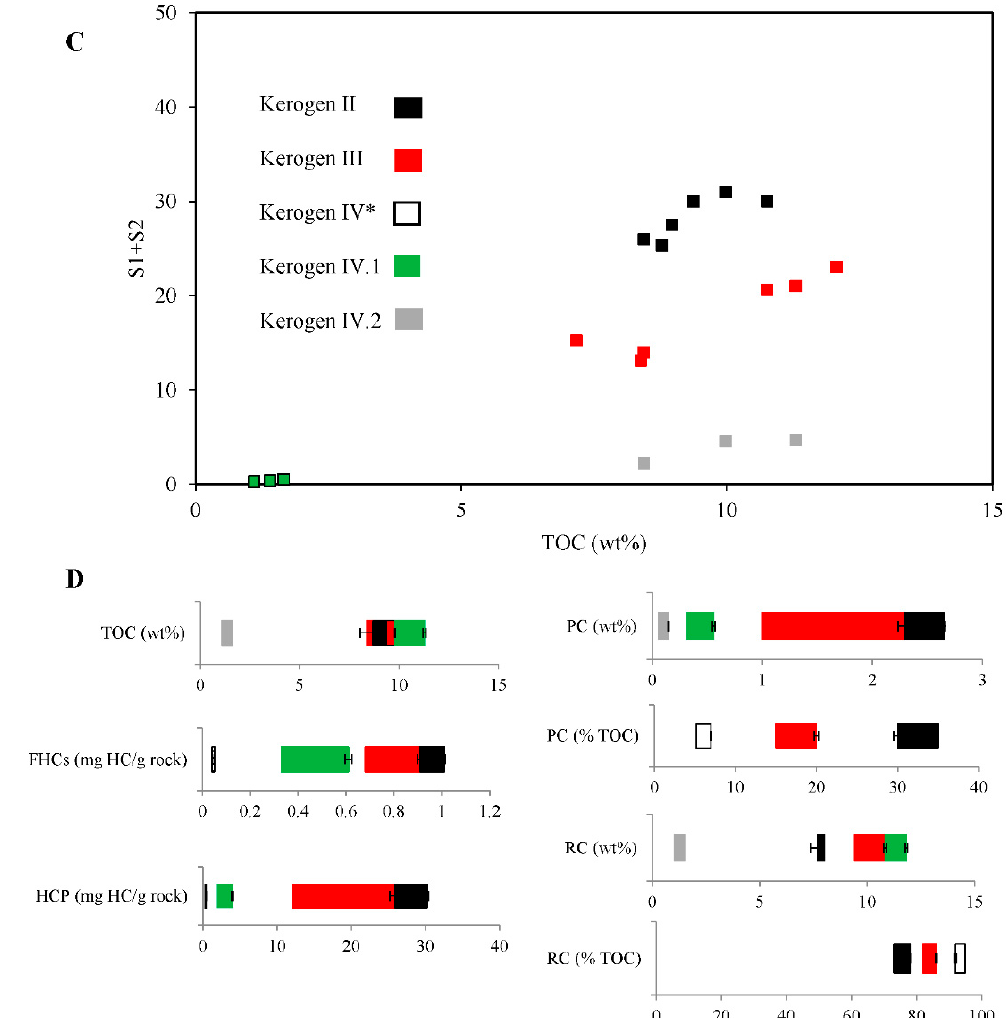
Figure 1. Pyrolytic characteristics of shale rock subjected to the Rock-Eval analysis. ( A ) Modified Van Krevelen diagram showing the correlation of hydrogen (HI) and oxygen index (OI). ( B ) HI and maturity temperature (T max ) crossed diagram. ( C ) Correlation of total organic carbon (TOC) and hydrocarbon potential (S1 + S2). ( D ) Ranges of pyrolytic parameters of kerogen (FHCs—free hydrocarbons; HCP—hydrocarbon potential; PC—pyrolytic carbon; RC—residual carbon). (*) Parameters whose values are similar for type IV.1 and IV.2 kerogen samples are presented together (white square), while those that differ significantly are presented separately (green and gray squares). All the differences are statistically significant (significance level: p < 0.05). The error bars represent standard deviation.